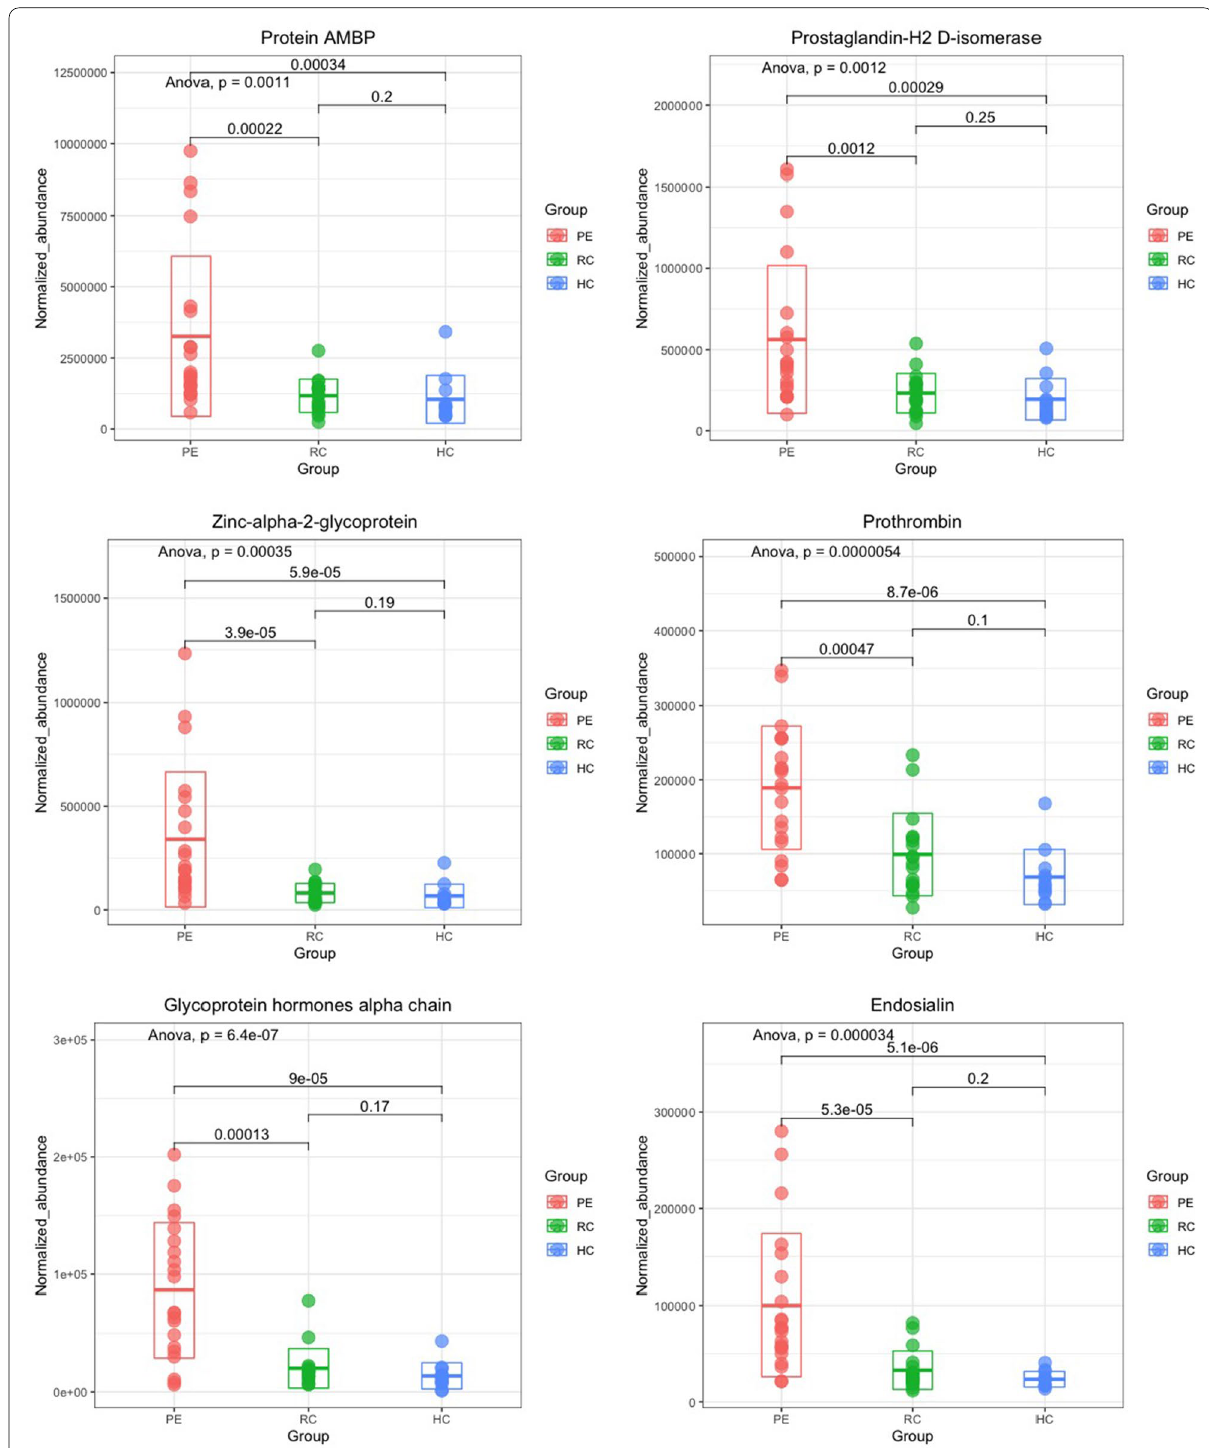
Fig. 4 Column scatter plots showing the normalized abundances of the six proteins presented. Samples from all three time points (12–14, 18–20, and 26–28 weeks of gestation) were included. Boxes indicate mean and standard deviation. PE